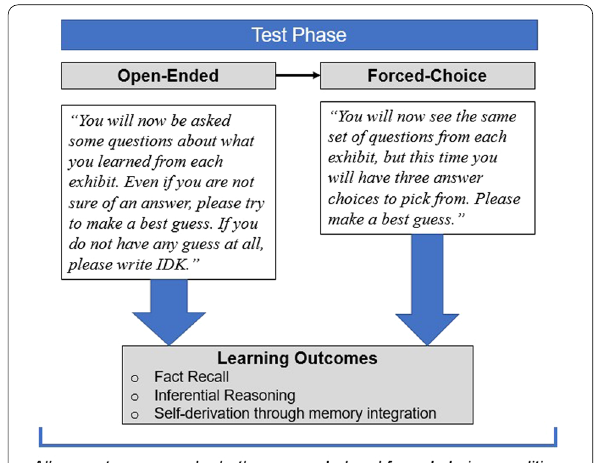
Fig. 2 Schematic of open-ended and forced-choice test